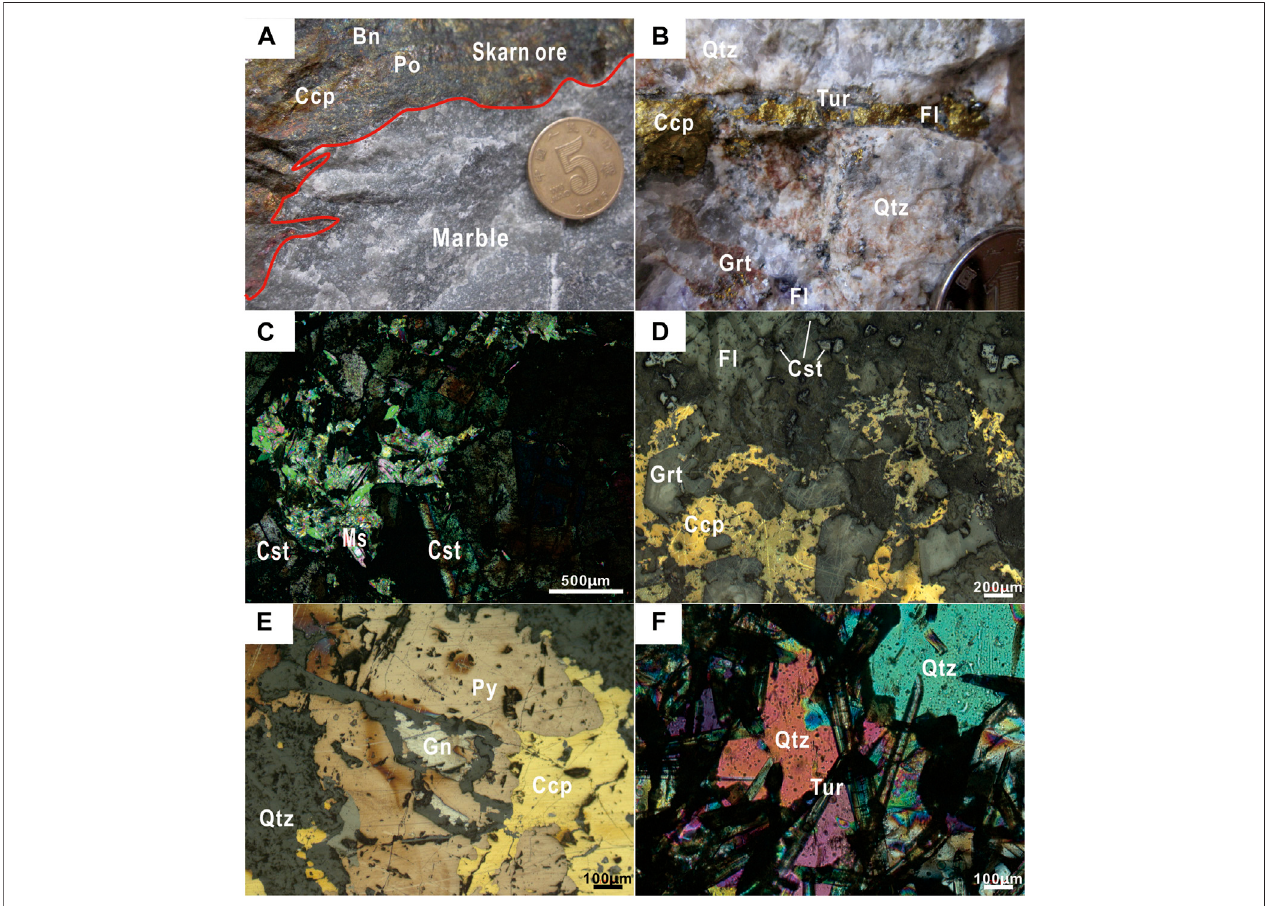
FIGURE3 | Hand specimensand microscopic photos showing the fi eld characteristics, alteration mineral associations, and their intergrowth – related relationships from the Gejiu Sn – Cu polymetallic ore deposit: Bn – bornite, Ccp – chalcopyrites, Cst – cassiterites, Fl – fl uorite, Gn – galena, Grt – garnet, Ms – mica, Po – pyrrhotite, Py – pyrite, Qtz – quartz, Tur –